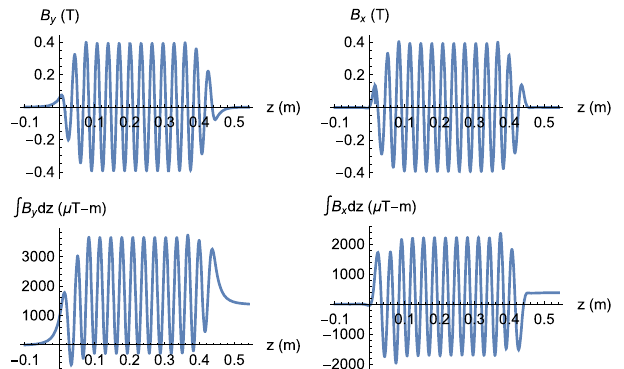
FIG. 17. HSCU vacuum chamber. Left: Al extrusions before machining; right: vacuum chamber is welded to the room temperature transition